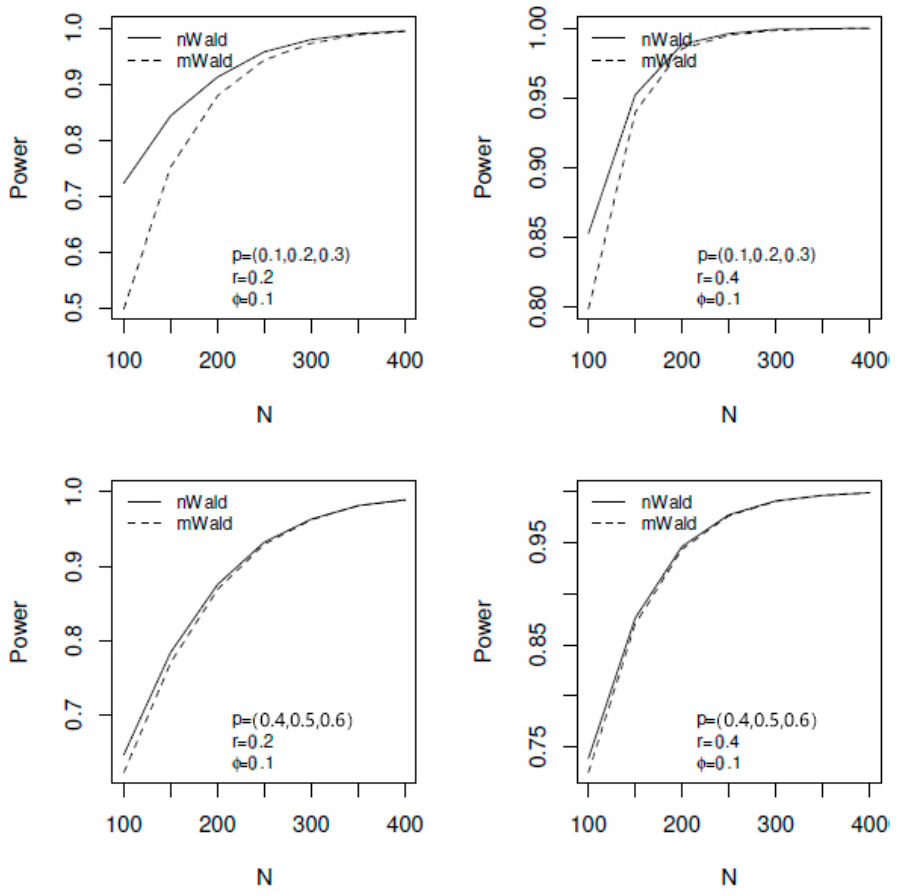
Figure 4. Power versus N with p = (0.1, 0.2, 0.3) for the upper two panels and with p = (0.4, 0.5, 0.6) for the lower two